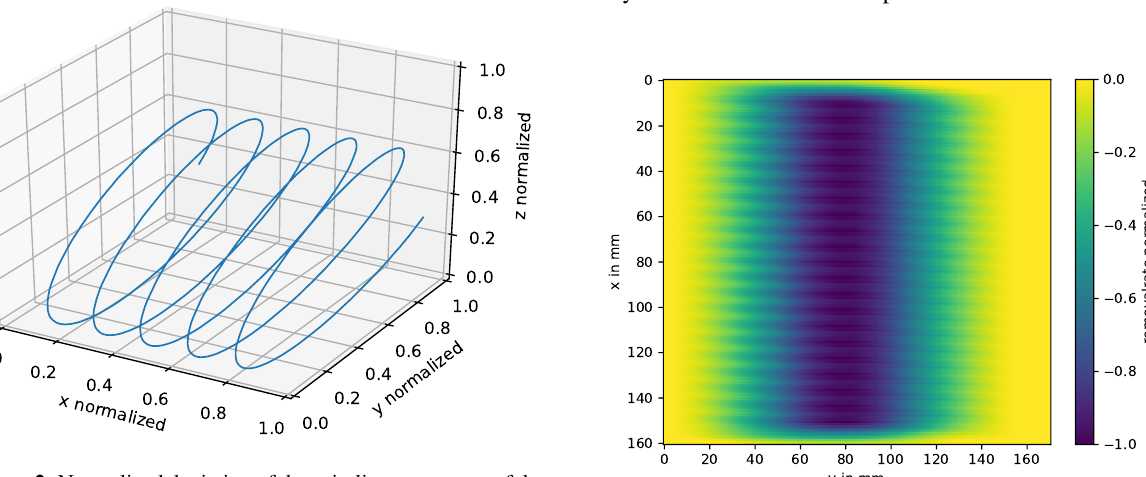
Figure 2. Normalized depiction of the spiraling movement of the irregularities on the ADAPT tool surface cf.[4]